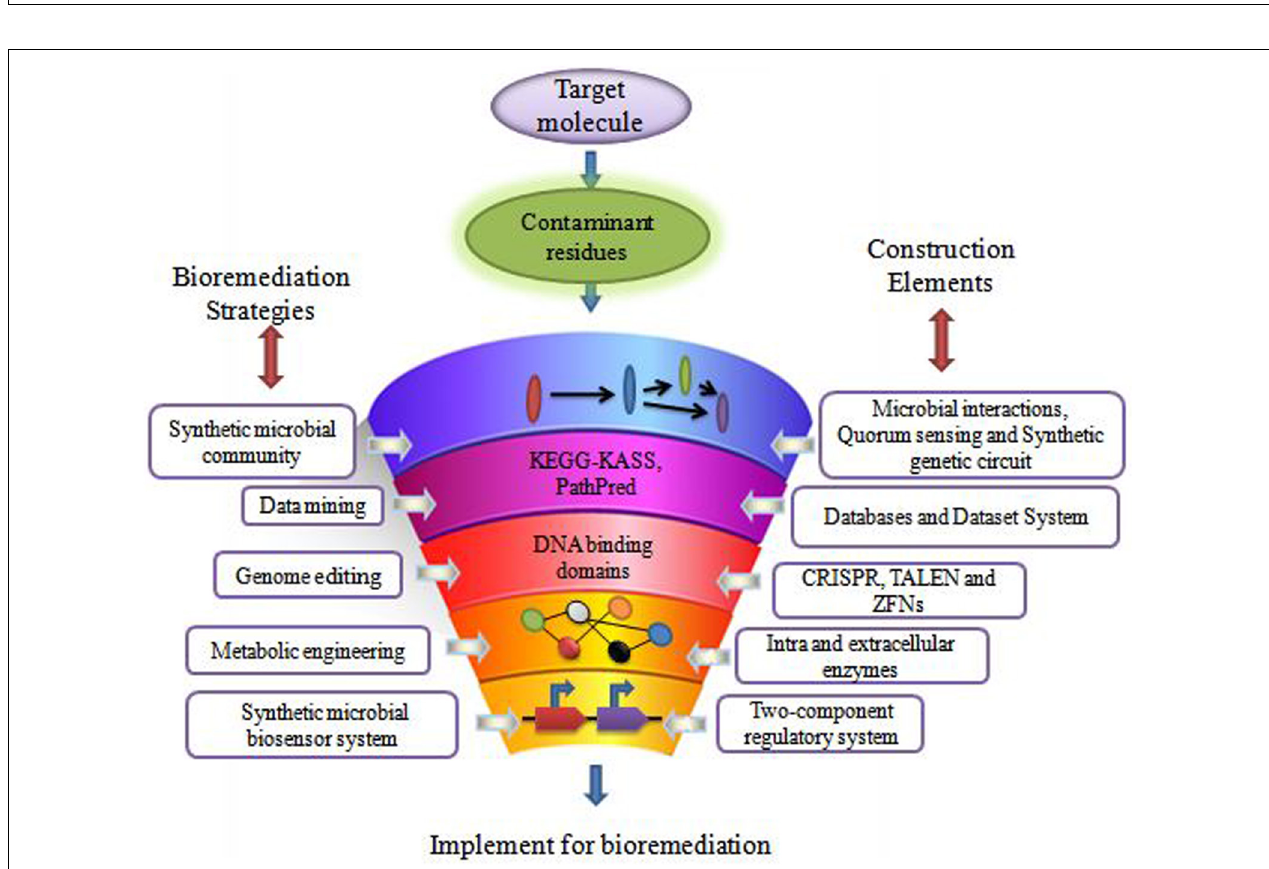
FIGURE 2 | The components and their construction elements of synthetic biology for bioremediation studies.